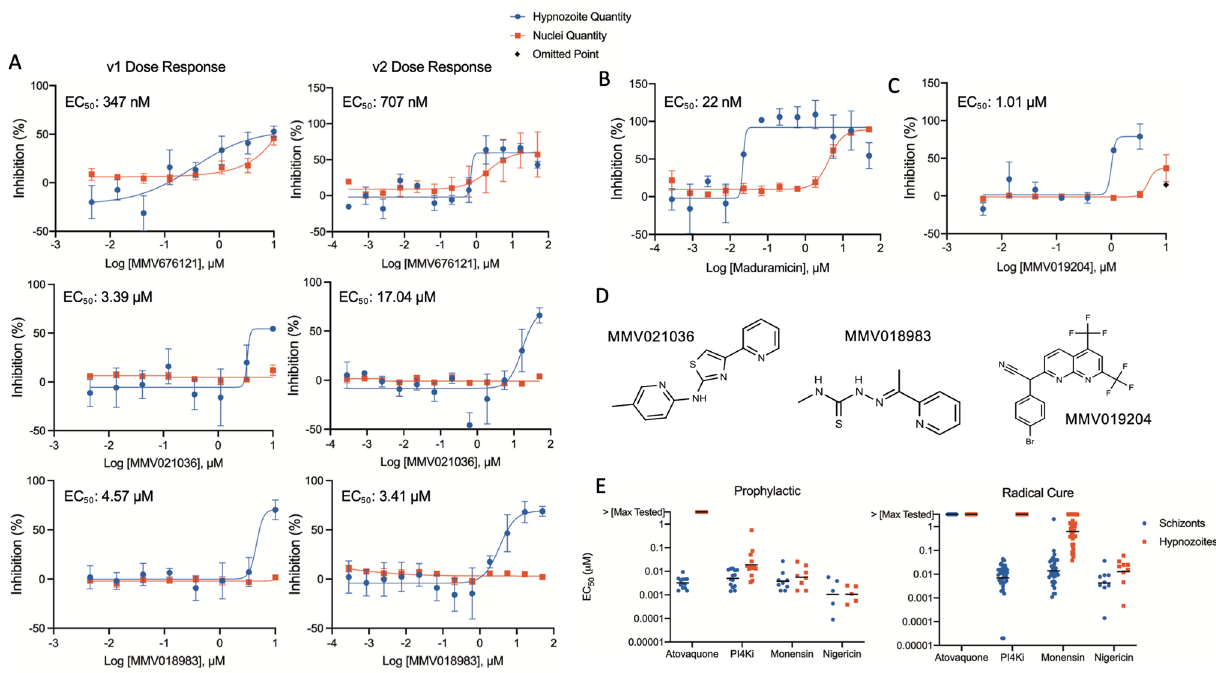
Figure 2. Examples of 8-day Radical Cure assay improvements used to characterize hits with activity against mature hypnozoites. ( A ) EC 50 ’s shown are for inhibition of hypnozoites. Possible hit MMV676121 was first identified from a run of the original dose response assay, which included a concentration gradient from 10 μM to 46 nM (v1). A CC 20 could not be calculated for inhibition of hepatic nuclei but was estimated to be > 2 μM. Bars represent SEM of 6 independent experiments, each with a single well at each concentration. MMV676121 was retested in the refined (v2) assay dose response format, which includes an expanded concentration gradient from 50 μM to 280 pM. Bars represent SEM of two independent experiments, each containing two wells at each concentration. Plotting inhibition of hepatic nuclei on the hypnozoite inhibition chart shows no selectivity window for this compound. The two assay versions were also used to identify and then further define the selective activity of two P. falciparum stage V gametocyte inhibitors, MMV021036 and MMV018983, against mature hypnozoites. Bars in the v1 charts represent SEM of three (for MMV021036) or four (for MMV018983) independent experiments, each with a single well at each concentration; bars in the v2 charts represent SEM of two independent experiments, each containing two wells at each concentration. ( B ) Radical Cure activity from a v2 assay of maduramicin against hypnozoites. Maduramicin is potently active against hypnozoites (EC 50 22 nM) and toxic against host hepatocytes (EC 50 4.28 μM), leading to a calculated selectivity of > 190. Bars represent SEM of two independent experiments, each containing two wells at each concentration. ( C ) Radical Cure activity from a v2 assay of P. falciparum stage V gametocyte inhibitor MMV019204, with activity against hypnozoites